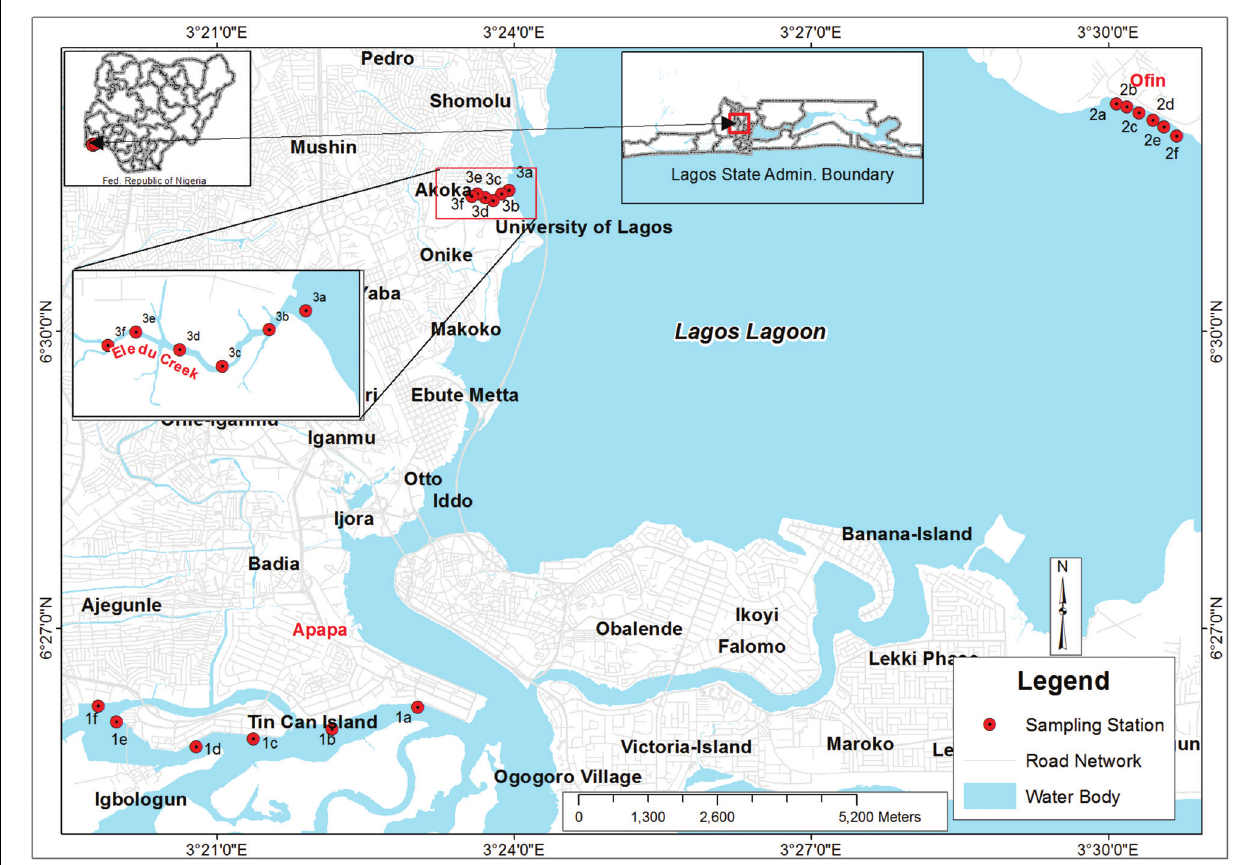
FIGURE 1 | Geographical map of the Lagos lagoon showing the sampling sites and stations. The sampling sites are given in red text: Apapa, Ofin, and Eledu. Expanded detail of the Eledu site is given in the